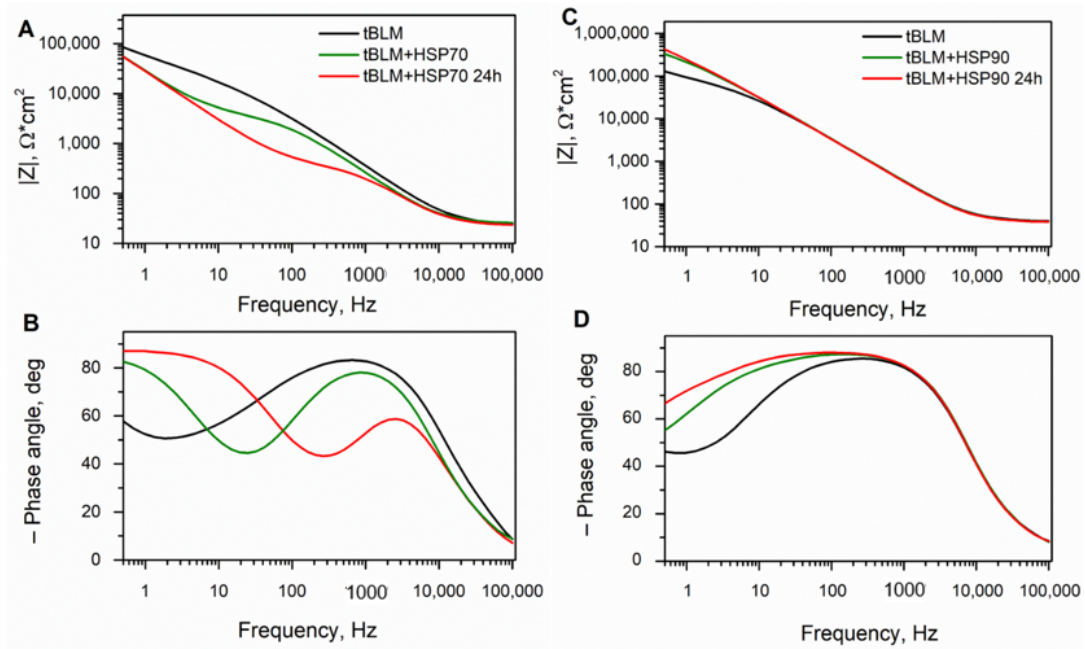
Figure 4. Interaction between HSP70 and HSP90 with tBLM: ( A ) impedance magnitude vs. frequency (Bode) plots and ( B ) Phase angle plot of EIS spectra: black, the initial spectra of tBLM; green, 10 min after HSP70 of 0.2 µ M injected; red, 24 h after injection of HSP70. tBLM was composed from DOPC:CHO (in ratio % 60:40); ( C ) Impedance magnitude vs. frequency (Bode) plots; and ( D ) Phase angle plot of EIS spectra: black, the initial spectra of tBLM; green, 10 min after HSP90 of 2 µ M injected; red, 24 h after injection of HSP90. tBLM was composed from DOPC and Cholesterol (in ratio % 75:25).